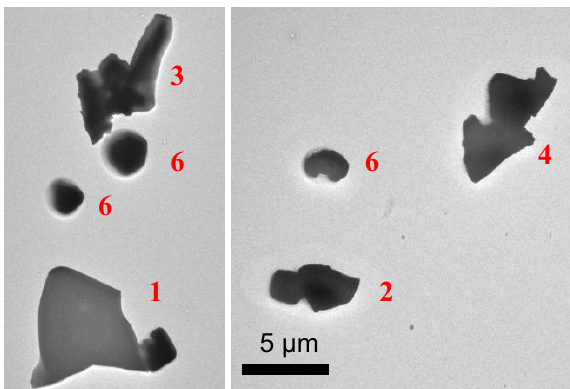
PM 1.8 − 11 μ m: Pure volcanic ash (1), mixed volcanic ash and sea salt (2 − 4), sea salt (6).